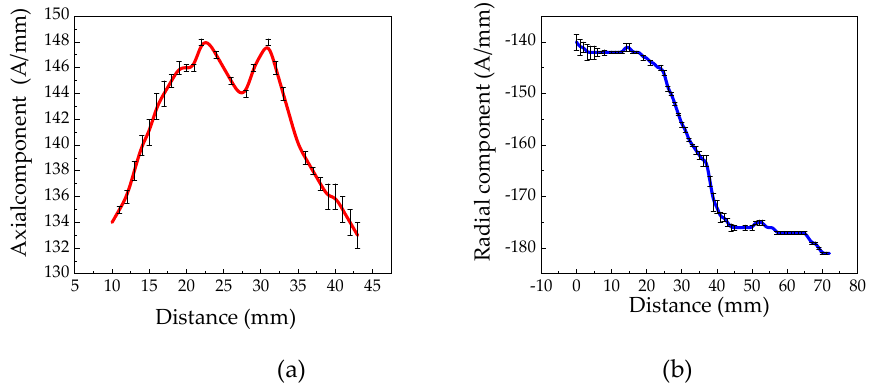
Figure 14. The characteristics of weak magnetic signal at the crack: ( a ) axial component and ( b ) radial component. An error bar illustrates standard deviation for the standard signal.